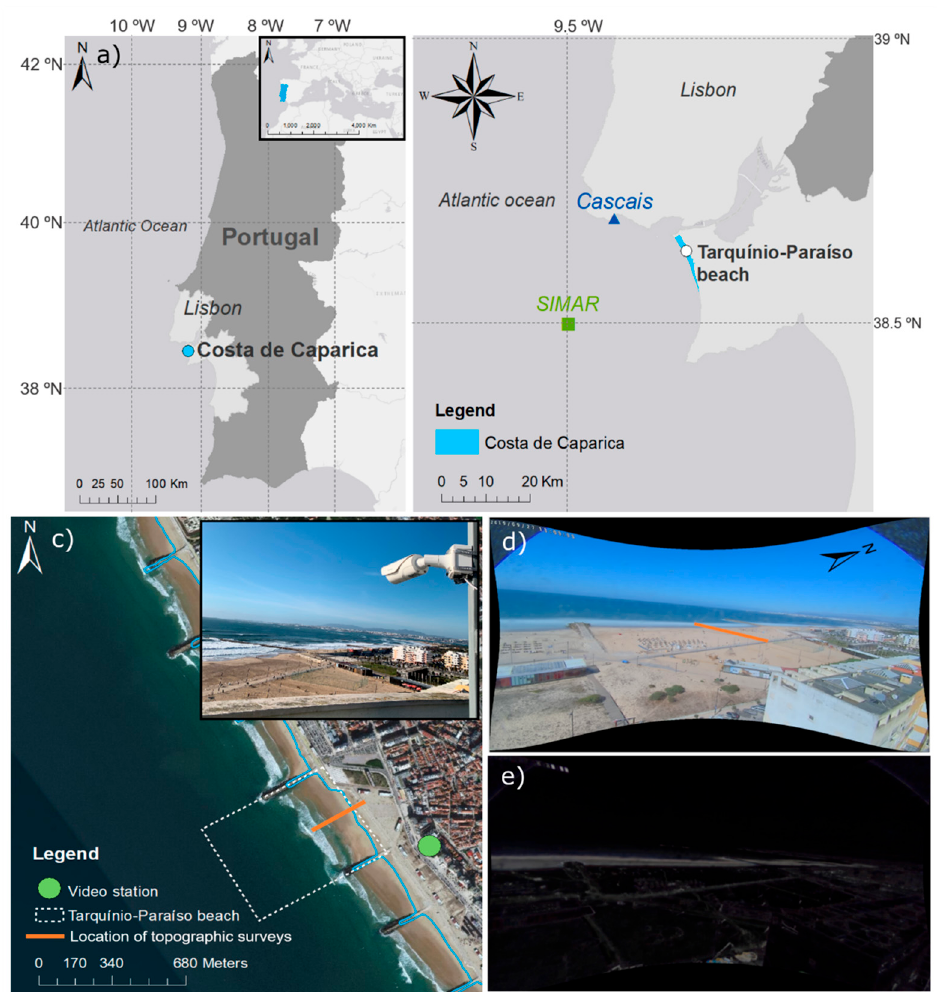
Figure 1. Study site map. ( a ) Location of Costa de Caparica; ( b ) location of Tarquínio-Paraíso beach (circle), Cascais tide gauge (triangle), and SIMAR point (square); ( c ) location of the video-station (in green) and of the cross-shore profile surveyed over the monitored period (orange, see Section 3.2); ( d ) Timex image and ( e ) Variance image.